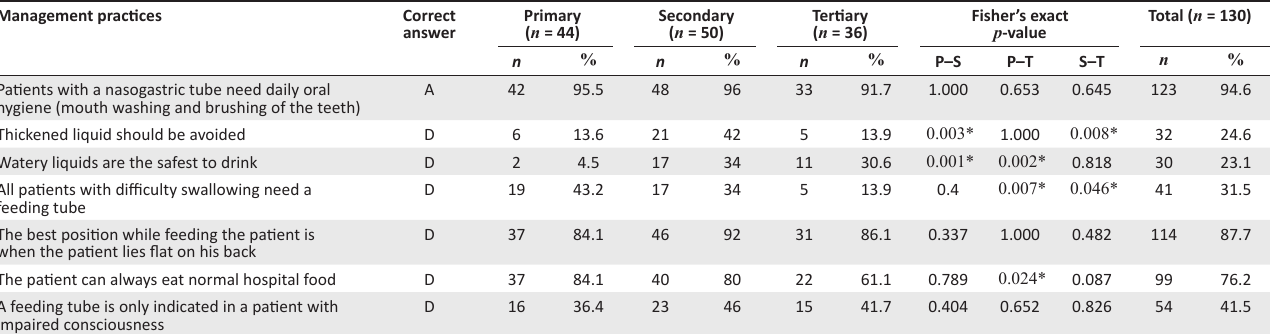
TABLE 4: Comparison of participants’ knowledge of the management of OPD ( N = 130)